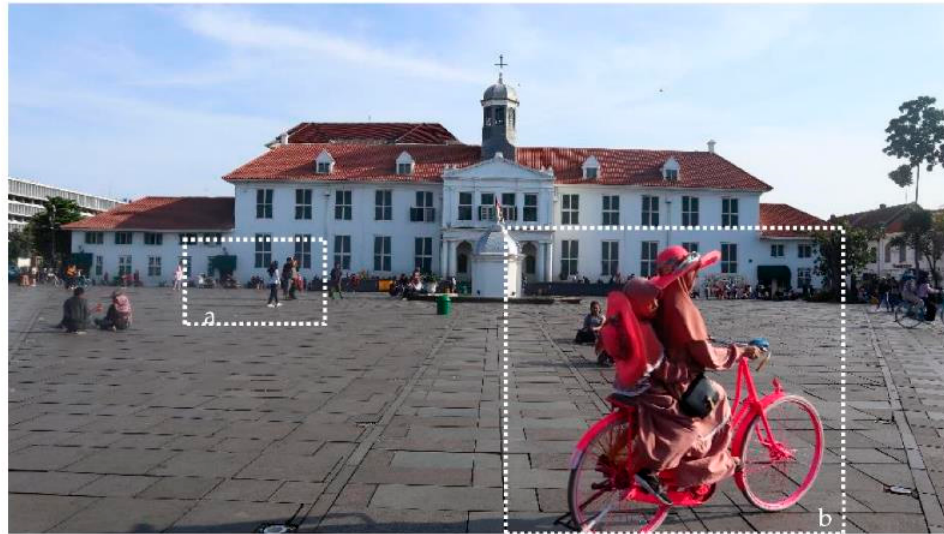
Figure 21. Portraits the condition of Fatahillah Square on weekday. Identified sound sources in the picture: ( a ) human voice ( b ) bicycle.